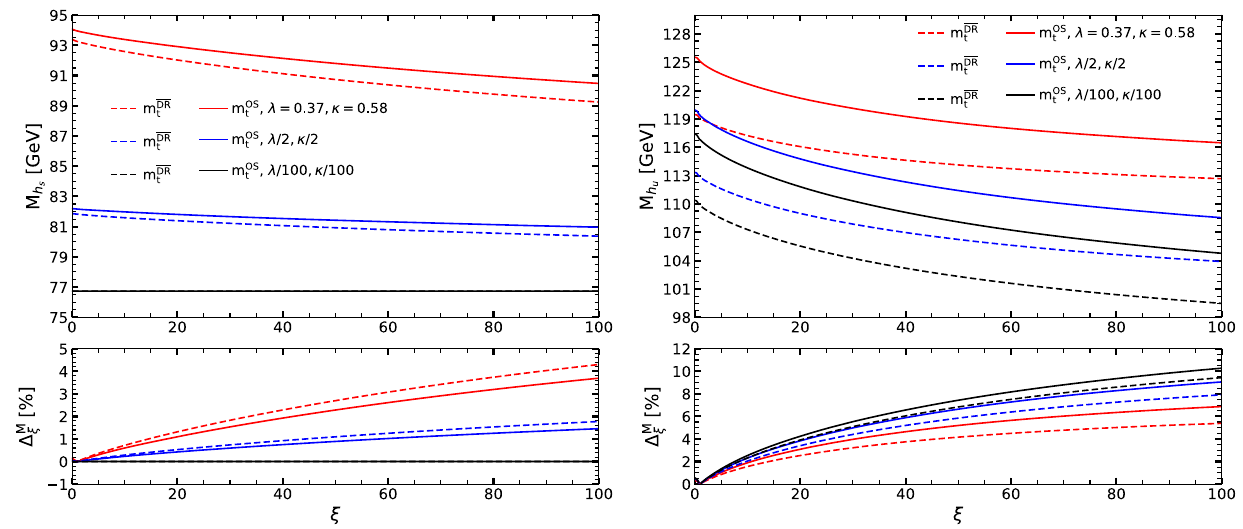
Fig. 6 Upper panel: The CP-even singlet-like (left) and the h u -like (right) Higgs boson masses at two-loop O (α t α s + α 2 t ) level in the OS (solid lines) and the DR (dashed lines) scheme of the top/stop sector